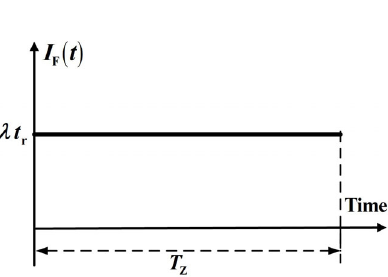
Fig. 5. Situation two’s stock level (in thicker lines) compared to a system with rework only (in thinner lines)